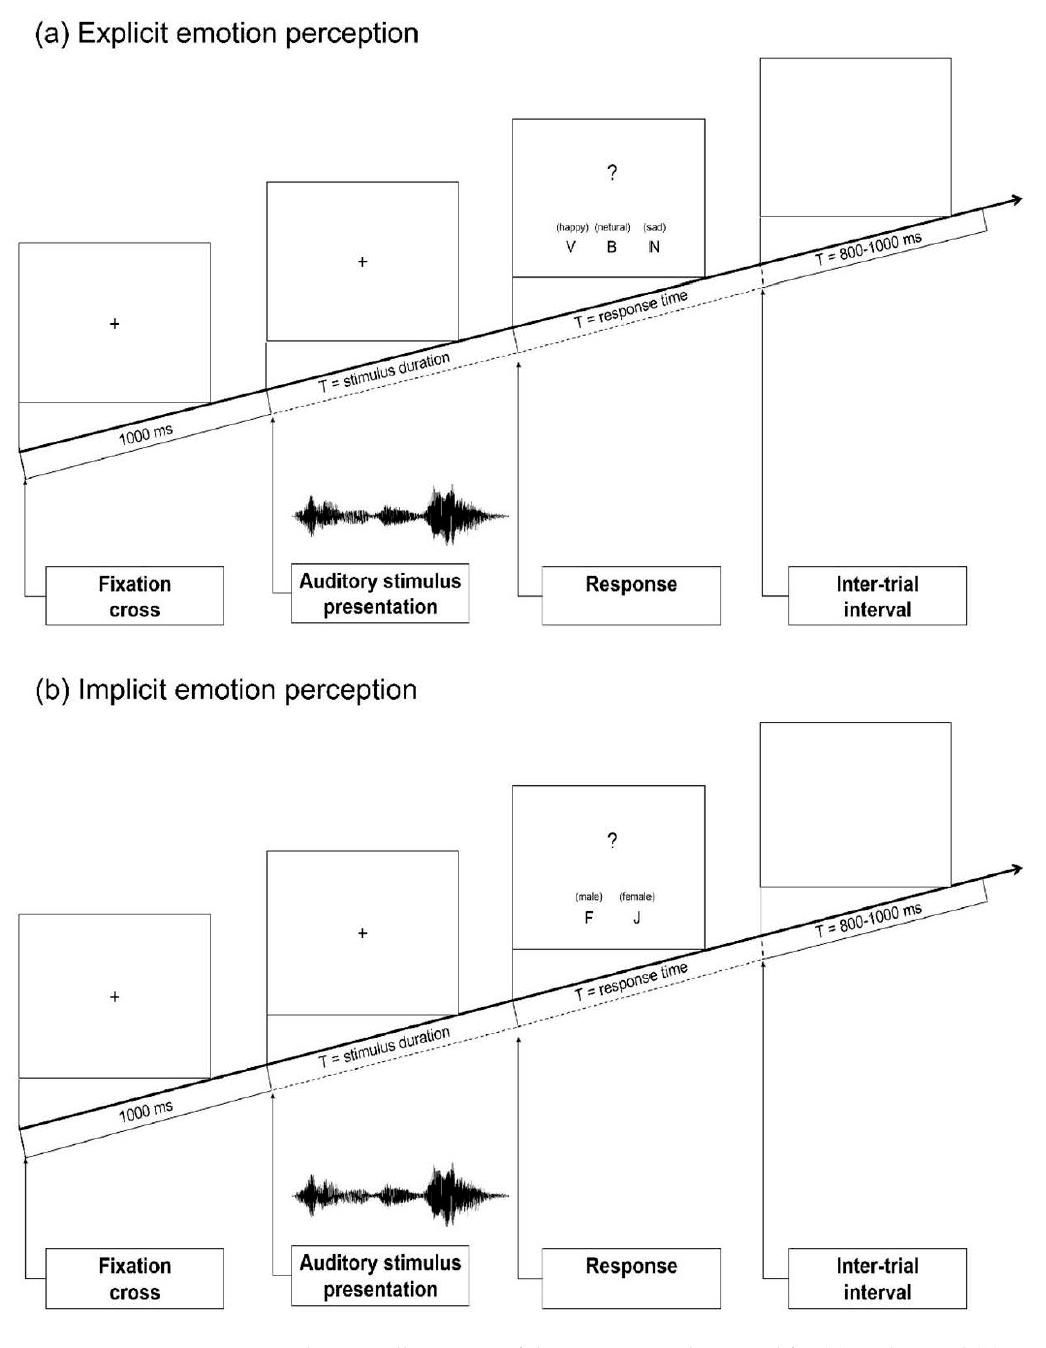
Figure 1. Schematic illustration of the experimental protocol for ( a ) explicit and ( b ) implicit emotion perception tasks.